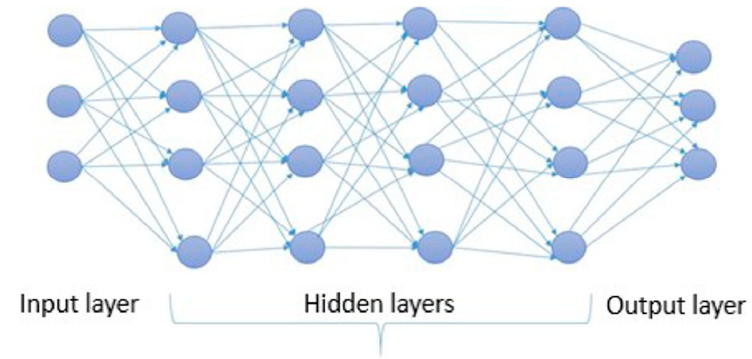
Figure 3. The structure of a deep neural network (DNN).